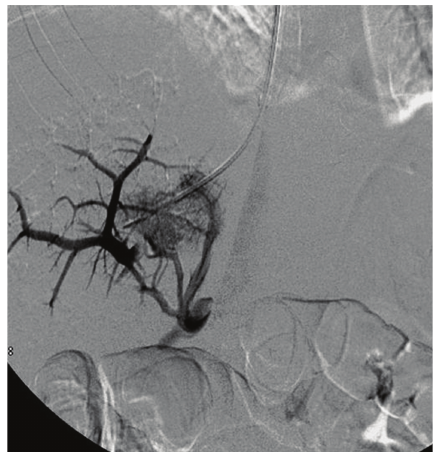
Figure 9: Transjugular portography in the same patient.